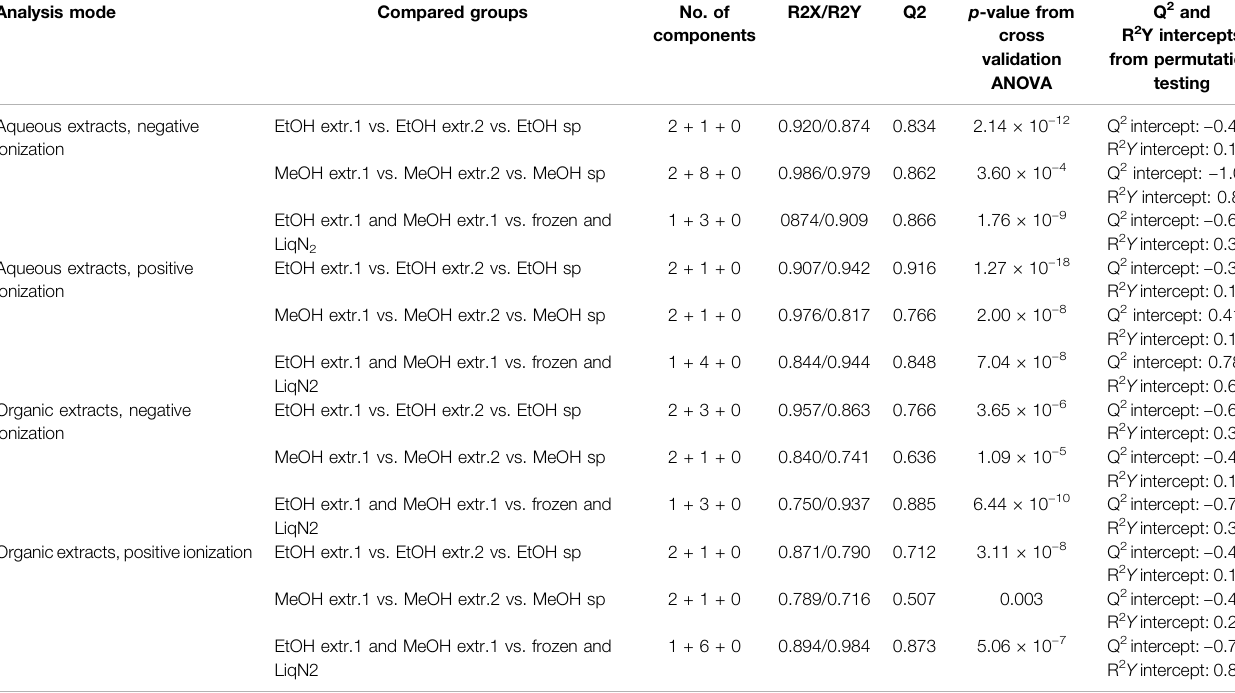
TABLE 3 | Summary of quality parameters from the OPLS-DA models. Analysis mode Compared groups